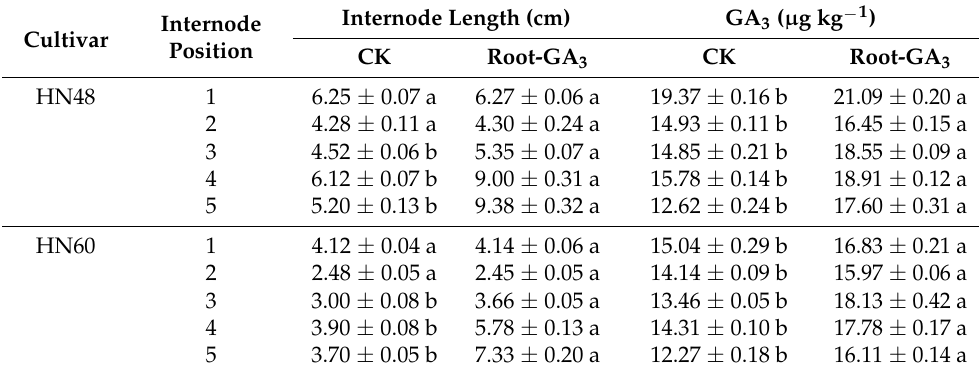
Table 3. Effects of GA 3 application to the roots of soybean plants on internode length and stem